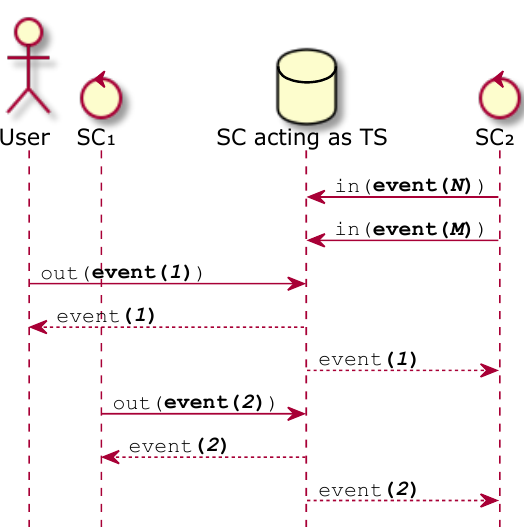
Figure 3. Tenderfone smart contract implementing a L INDA tuple space exploited to coordinate two other smart contracts according to the barrier pattern. Straight lines represent primitive invocations, whereas dashed lines represent primitive